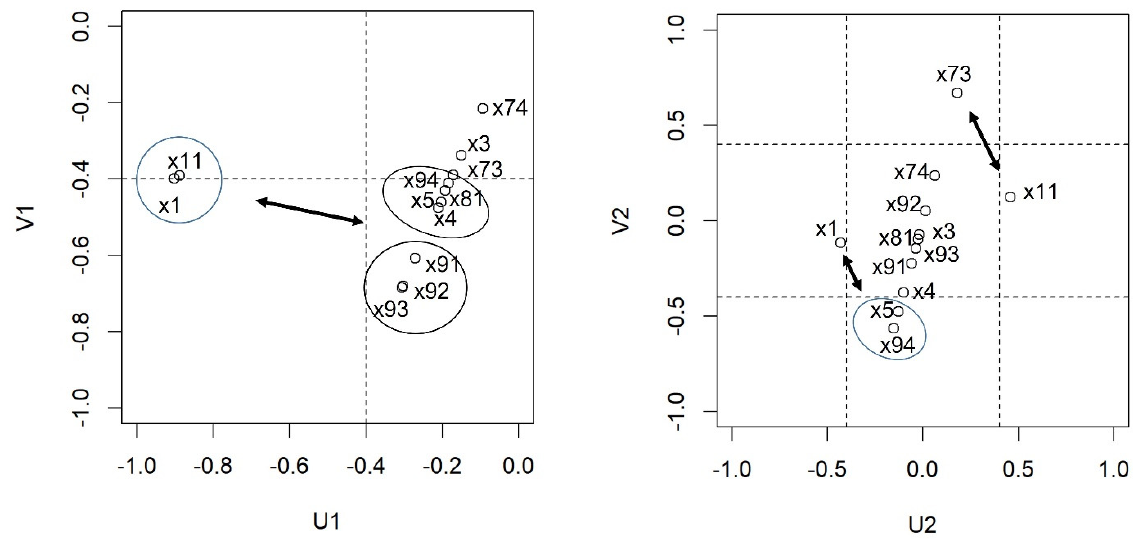
Figure 1. Correlations between the studied variables and the canonical varieties. First variety U1. Second variety U2.